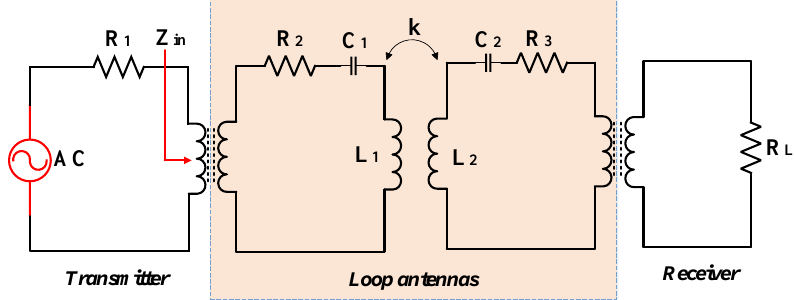
Figure 11. Equivalent circuit of the WPT system with two loop